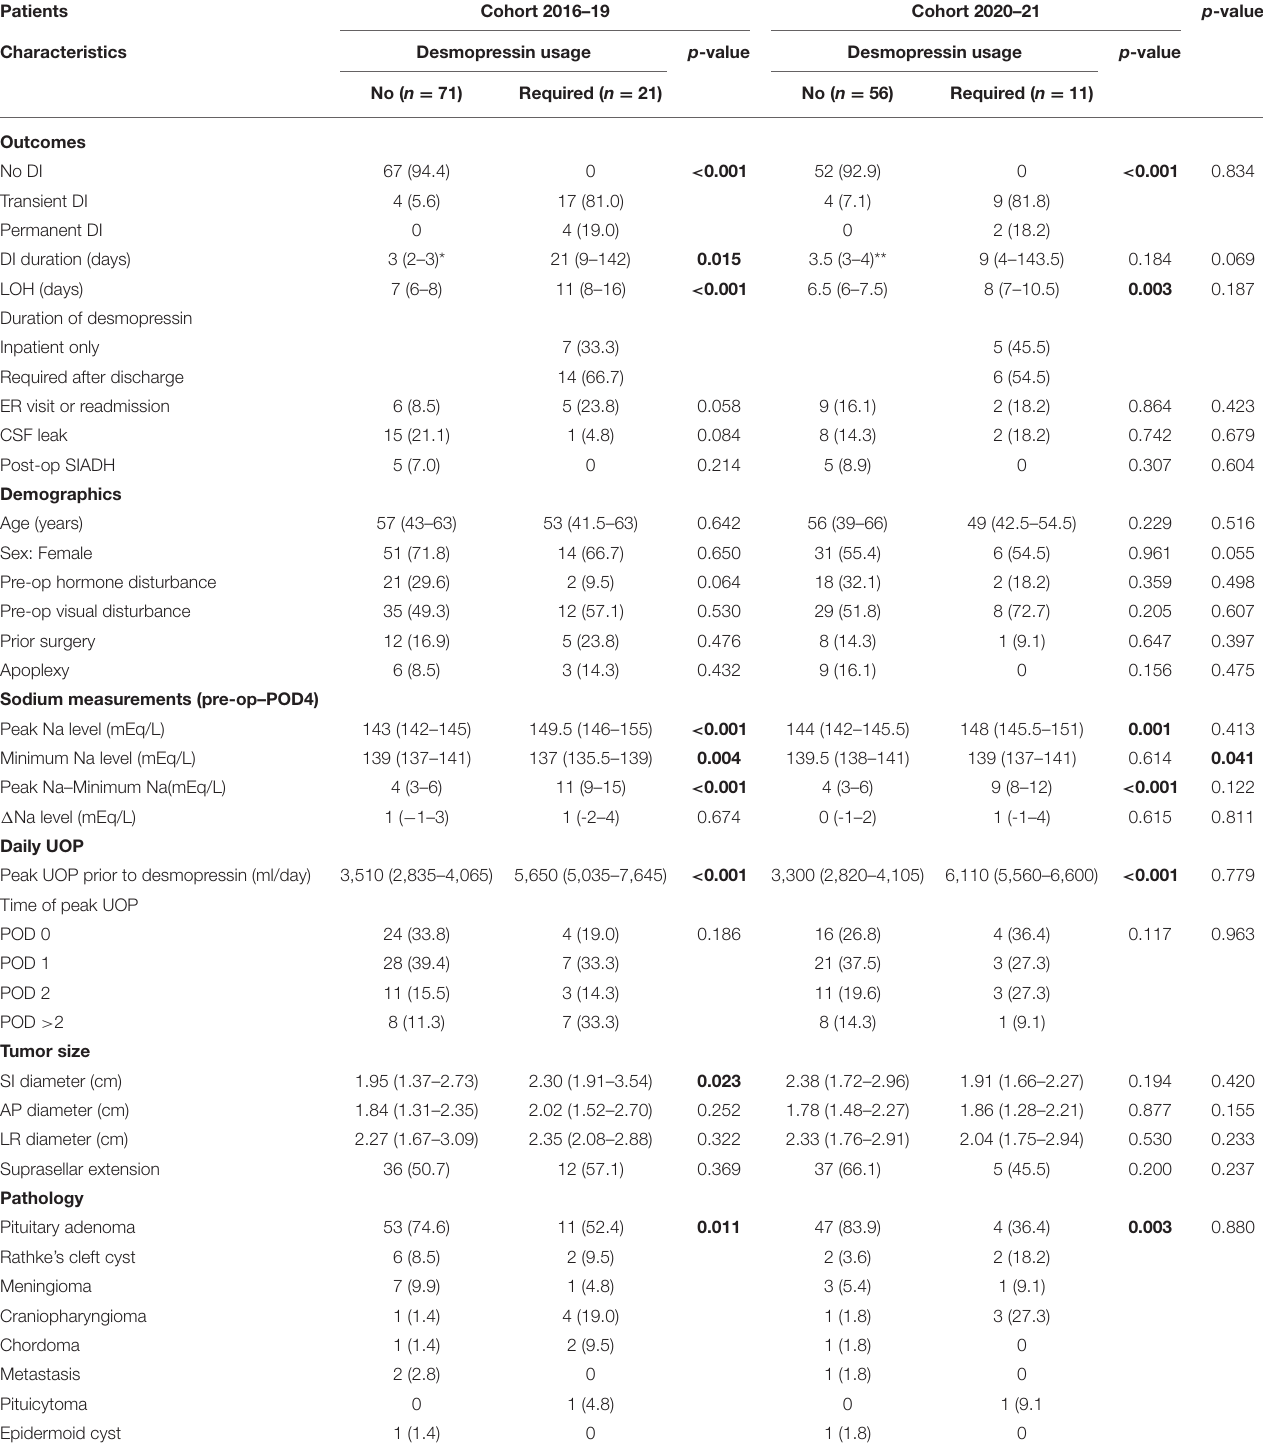
TABLE 1 | Demographics and outcomes in patients undergoing EEA for sellar pathologies.